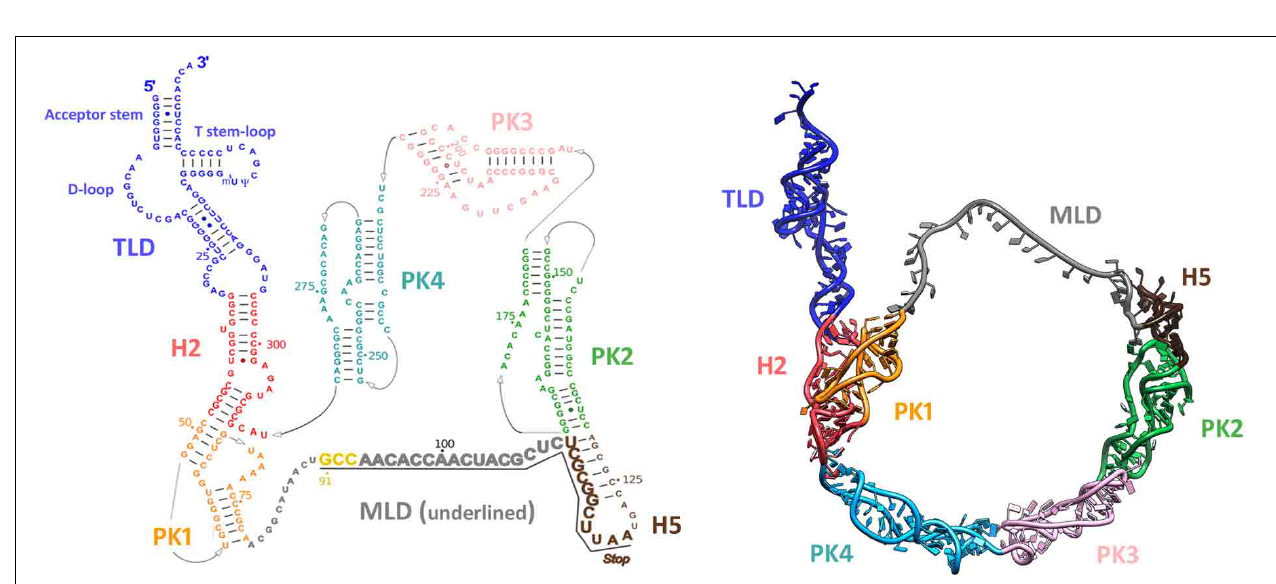
FIGURE 2 | Structure of tmRNA. Left: Diagram of the secondary structure of Thermus thermophilus tmRNA. Watson-Crick base pairs are connected by lines, and GU pairs are represented by dots. Domains are highlighted with colors: tRNA-like domain (TLD) is blue; helix 2 (H2) is red; pseudoknot 1 (PK1) isorange;thesinglestrandportioncarryingthemessenger-likedomain(MLD)is gray; helix 5 (H5) is brown, pseudoknot 2 (PK2) is green; pseudoknot 3 (PK3) is